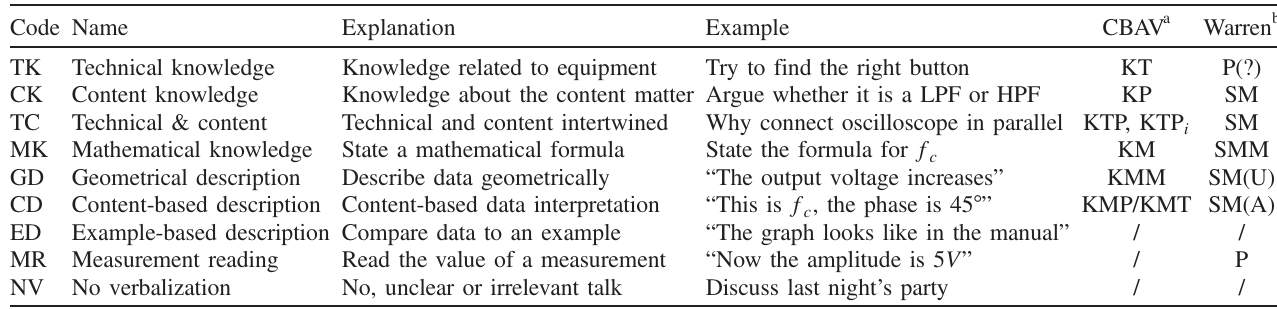
TABLE VI. Categories for verbalization. Code